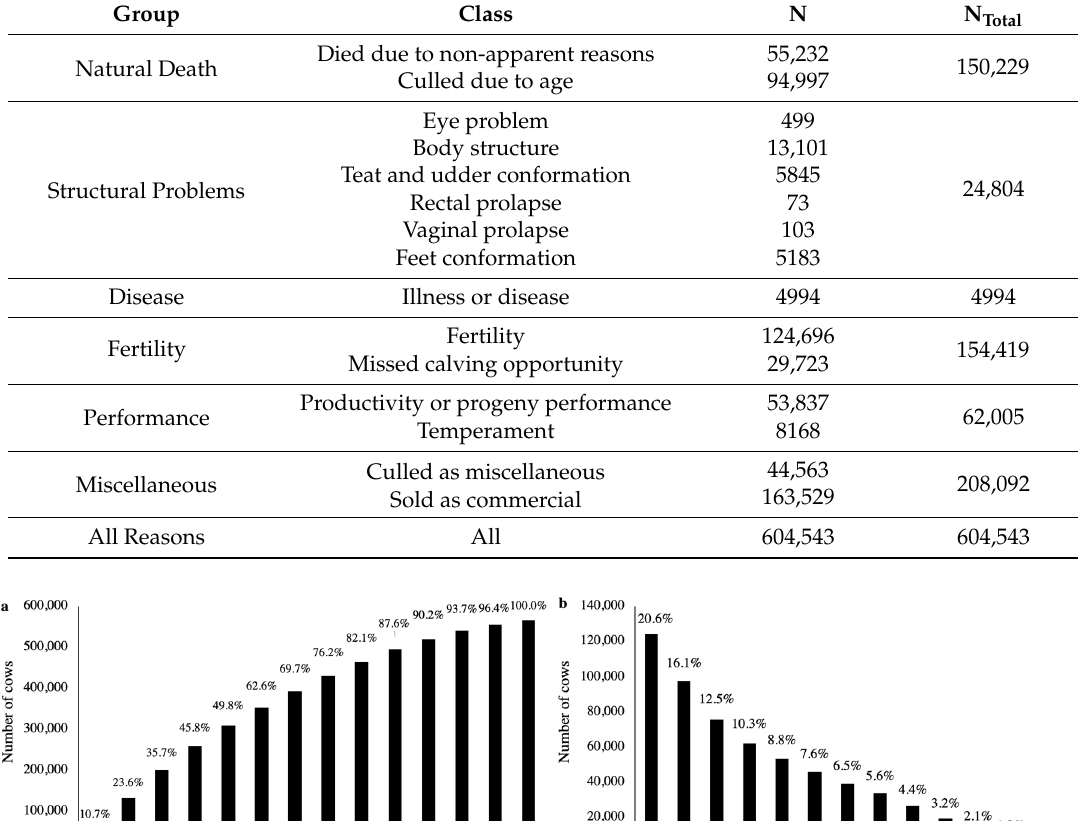
Table 1. Description of the di ff erent groups of culling reason in North American Angus cattle.